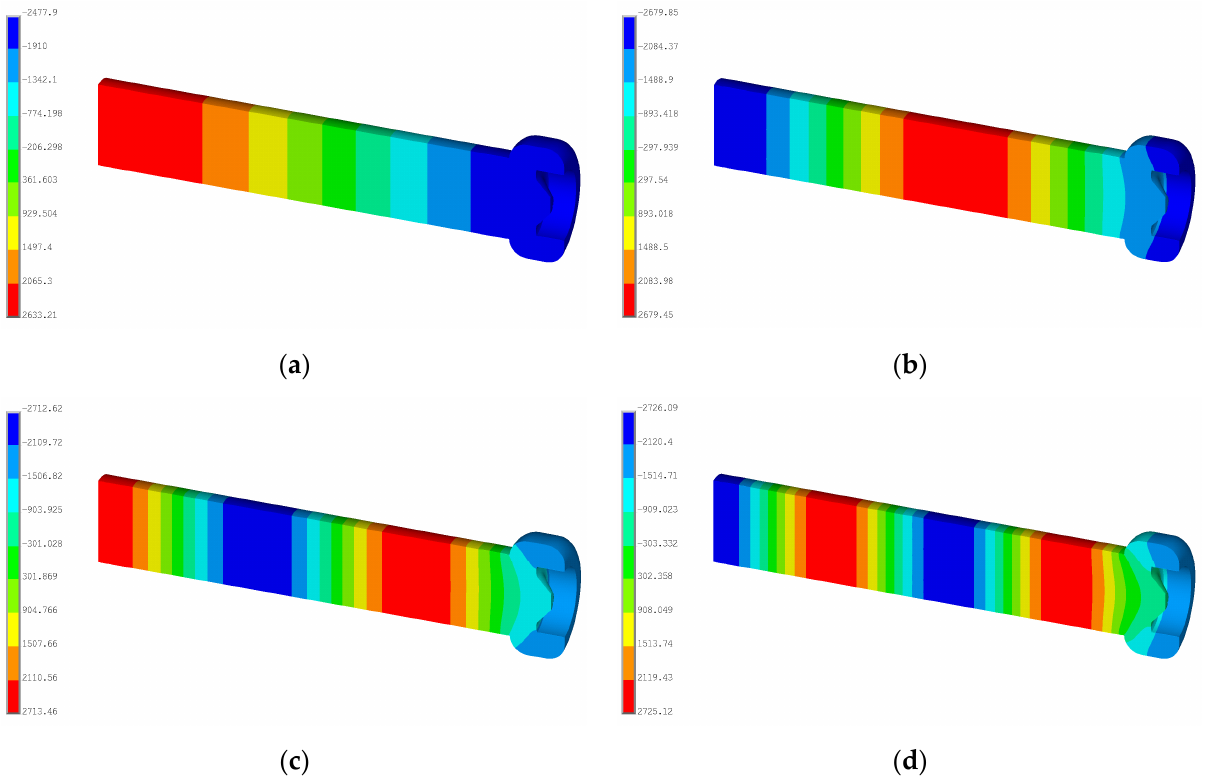
Figure 6. The first four acoustic mode shapes of case C0. ( a ) First ‐ order acoustic mode shape. ( b ) Second ‐ order acoustic mode shape. ( c ) Third ‐ order acoustic mode shape. ( d ) Fourth ‐ order acoustic mode shape.